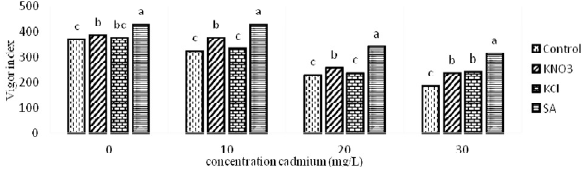
Fig. 7. Vigor index of unprimed (UPS) and primed (PS) seedling of fenugreek ( Trigonella foenum-graecum L.) under different Cd concentrations Vigor index was measured in unprimed seeds and when seeds were primed by 100 mg/L SA and -1 MPa KNO 3 and KCl solution for 24 h. The unprimed seeds were used as the control. Means with similar letters were not significantly different (p ≤ 0.05) based on LSD